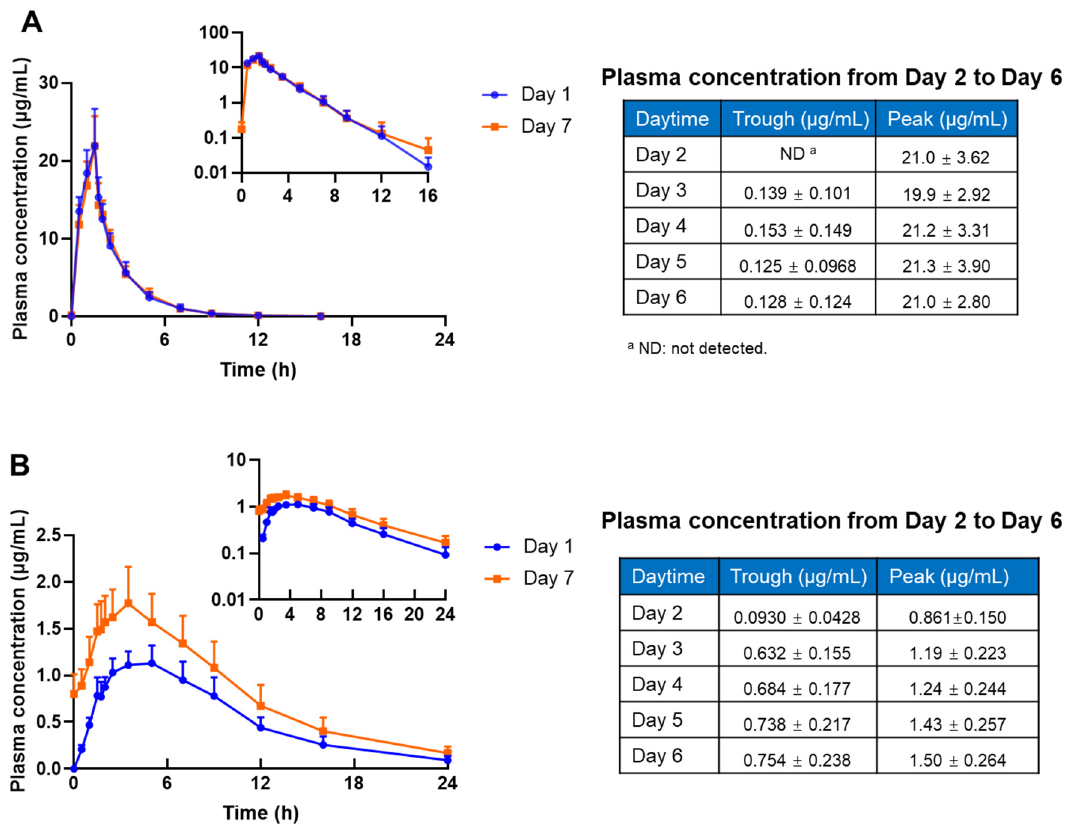
Figure 1. Mean plasma concentration–time profiles of CMS ( A ) and colistin ( B ) in healthy subjects after treatment with CMS injections at 2.5 mg/kg CBA 7 consecutive days (subjects were dosed every 12 h from days 2 to 6, with a single dose on days 1 and 7; data are expressed as the mean and standard deviation of 12 subjects).